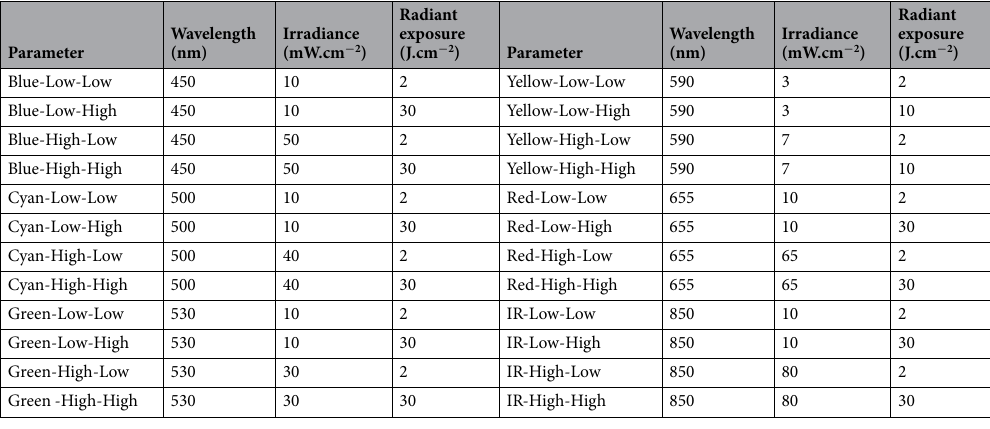
Table 1. Light parameters used for treatment of human dermal fibroblasts following a factorial design of